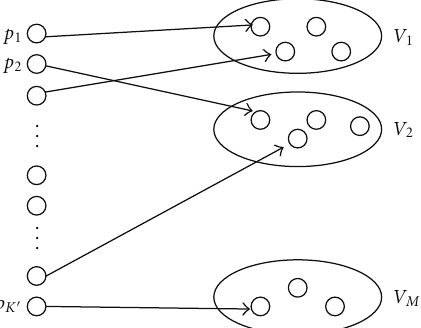
Figure 12: Illustration of the reduction from an SUPM problem to a BF-NC-based scheduling